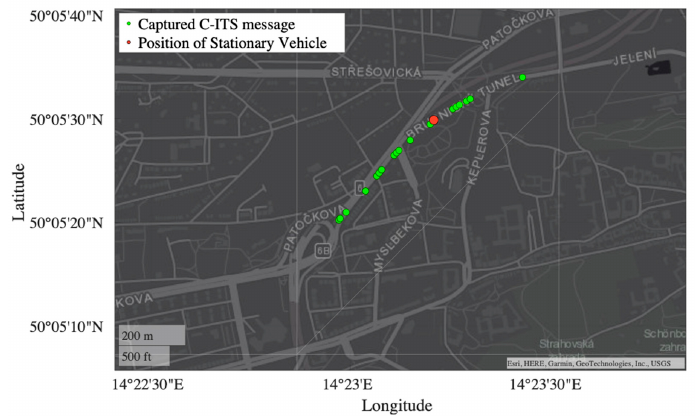
Figure 9. Captured V2X communication over ITS ‐ G5.